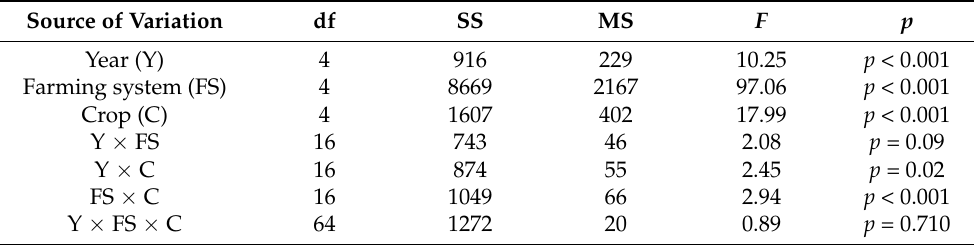
Table 4. Analysis of variance for soil microbial hydrolytic activity ( µ g fluorescein g − 1 soil dry weight h − 1 ) depending on year, farming system, crop, and their